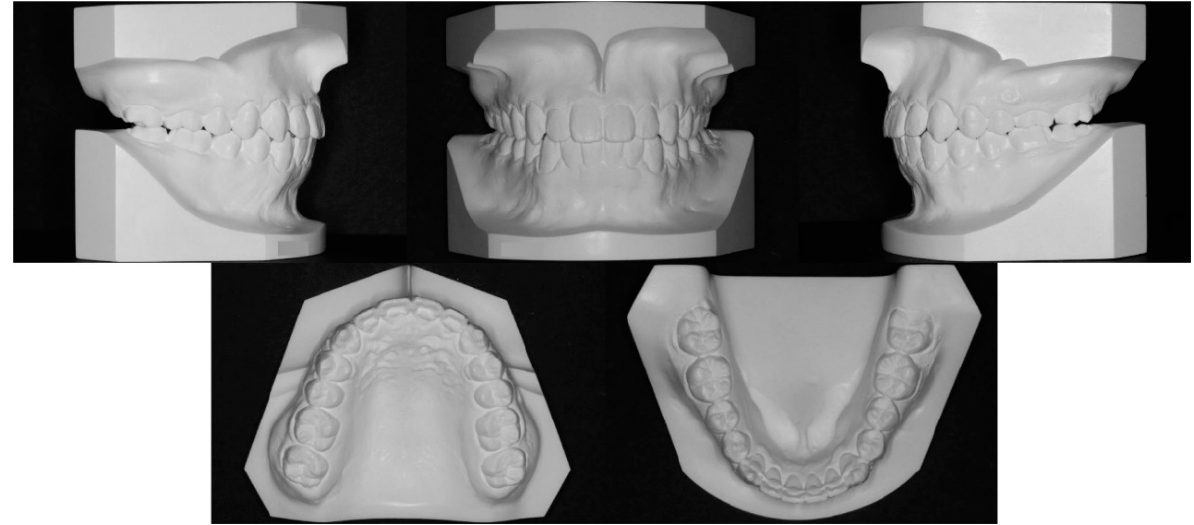
Figure 7. Post-treatment dental casts.